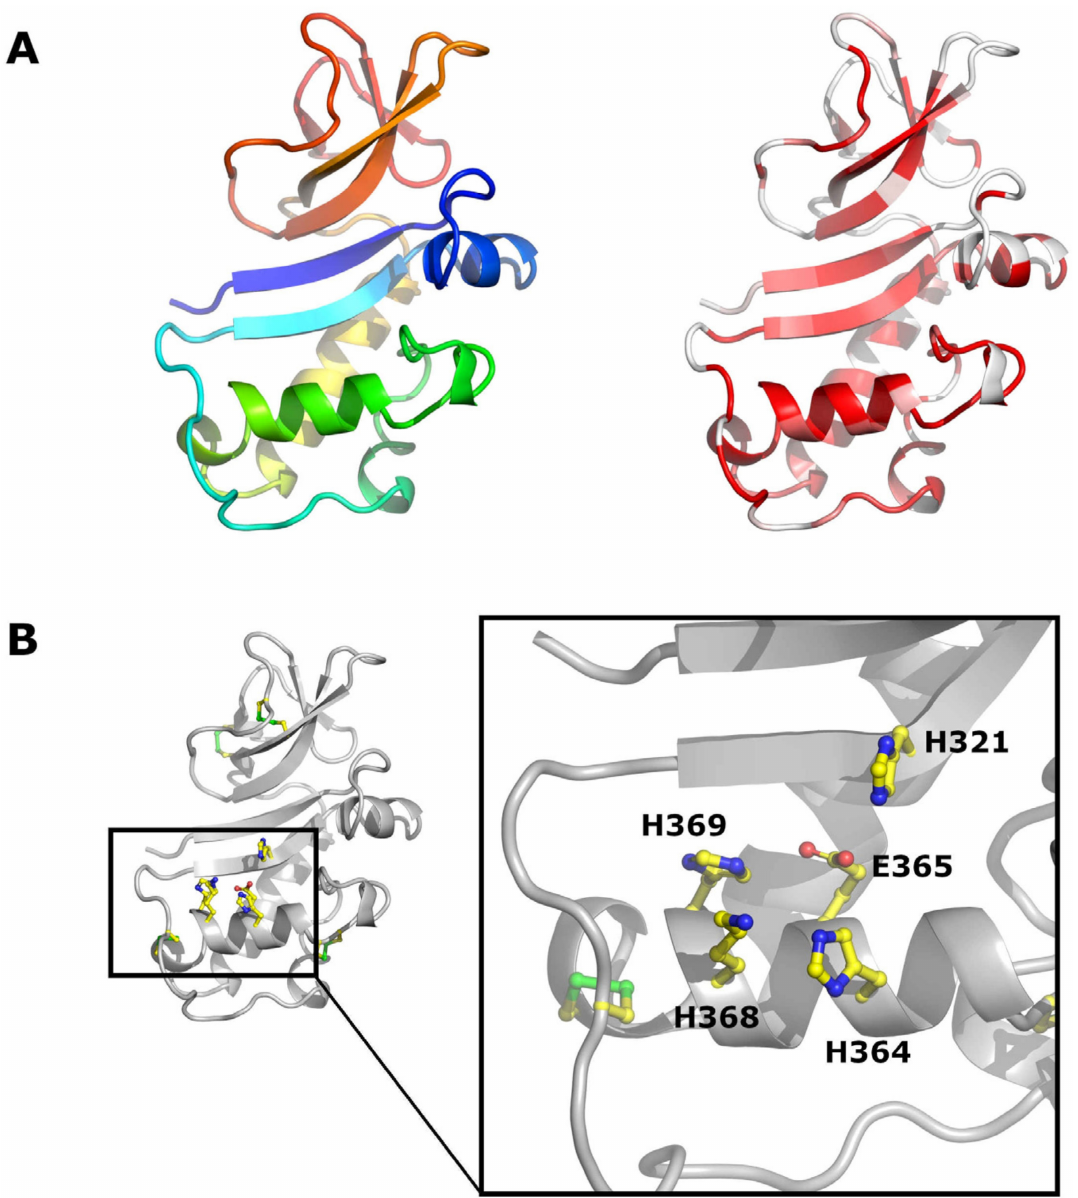
Figure 5. Crystal structure of E rns . ( A ) Cartoon representation of E rns (PDB code 4DWC). On the left, E rns is coloured from the N terminus (blue) to the C terminus (red). On the right, E rns is coloured according to sequence conservation from white (non-conserved) to red (conserved). ( B ) Disulfide bridges and residues of the active site are shown as